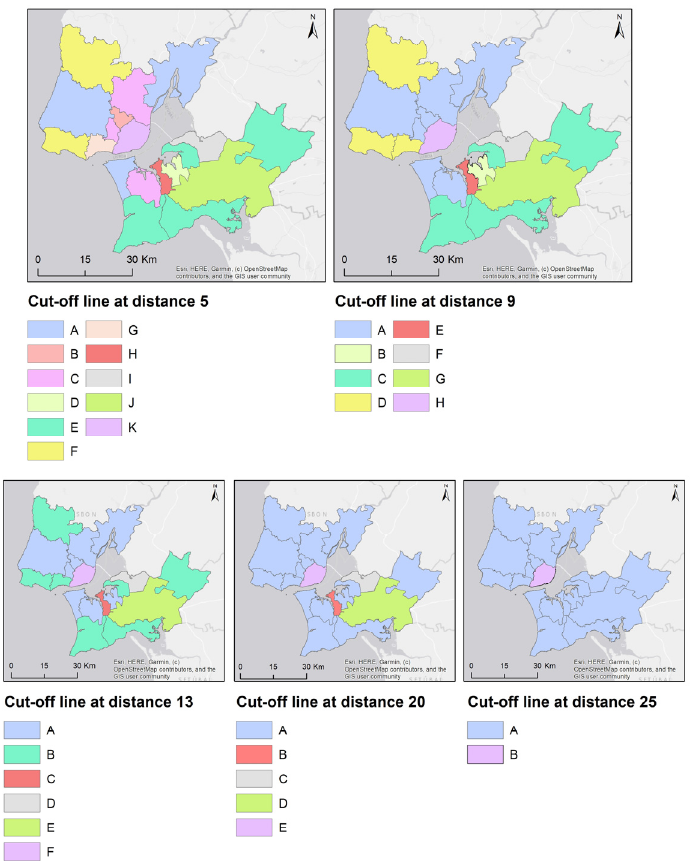
Figure 6. Spatial pattern based on cluster analysis (cut-off lines at distances 5, 9, 13, 20, and